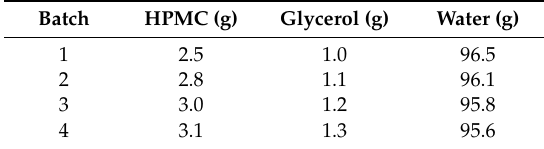
Table 1. Compositions for the studied blank (drug-free)